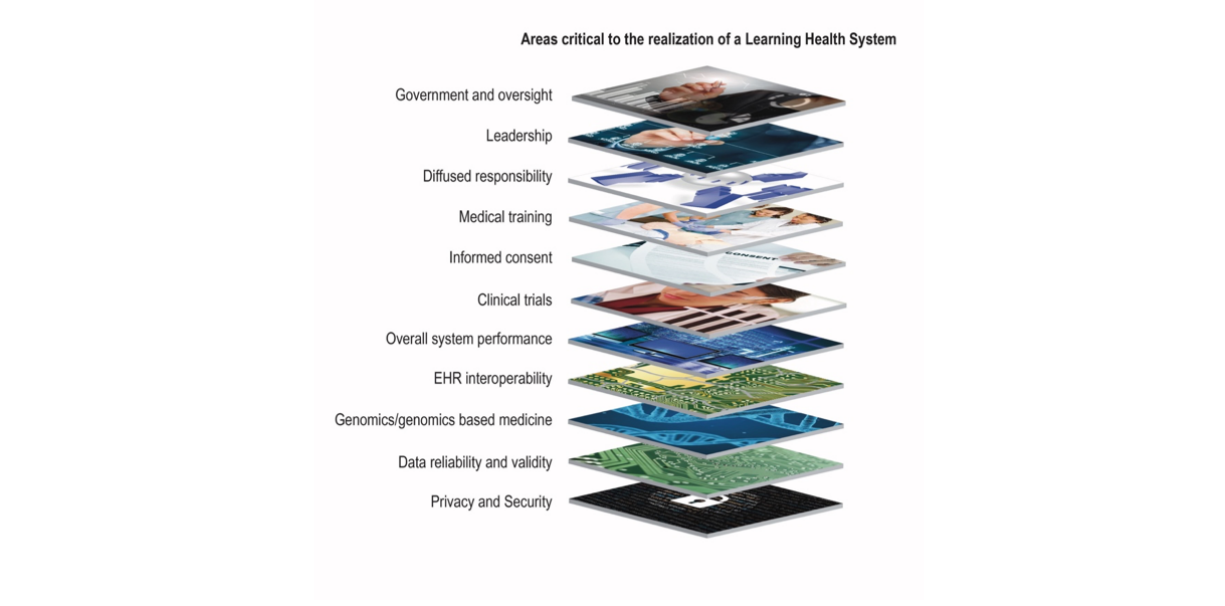
Figure 1. Areas critical to the realization of a learning health